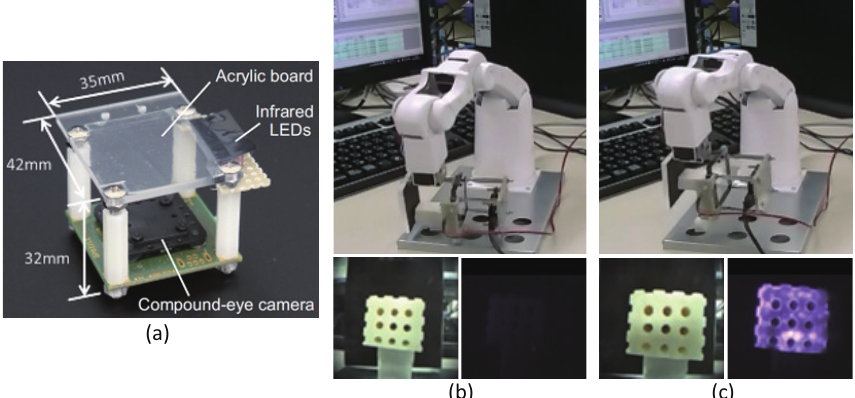
Figure 3. Example of tactile image sensor using a camera based on the light conducted plate. ( a ) Picture of the combined contact and proximity sensor ( c (cid:13) IEEE 2016. Reprinted with permission from [25]); ( b , c ) application to robotic grasp control. The bottom row shows the output images including the contact detection (shown by purple color) and the visible light image of the object in the